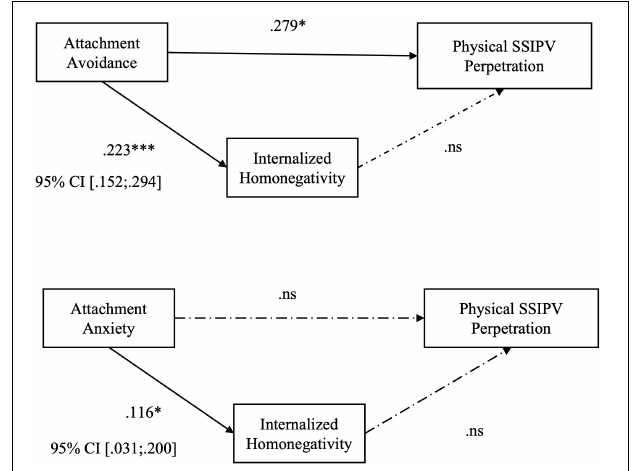
FIGURE 2 | Hp.1. Path analysis with Total score of Perpetrated SSIPV as the outcome, Total score of MISS as the mediator, and the score of Anxiety and Avoidance dimensions as the predictors. * p < 0.05; ** p < 0.01; *** p < 0.001.